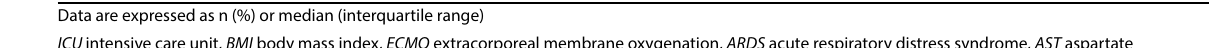
Data are expressed as n (%) or median (interquartile range)